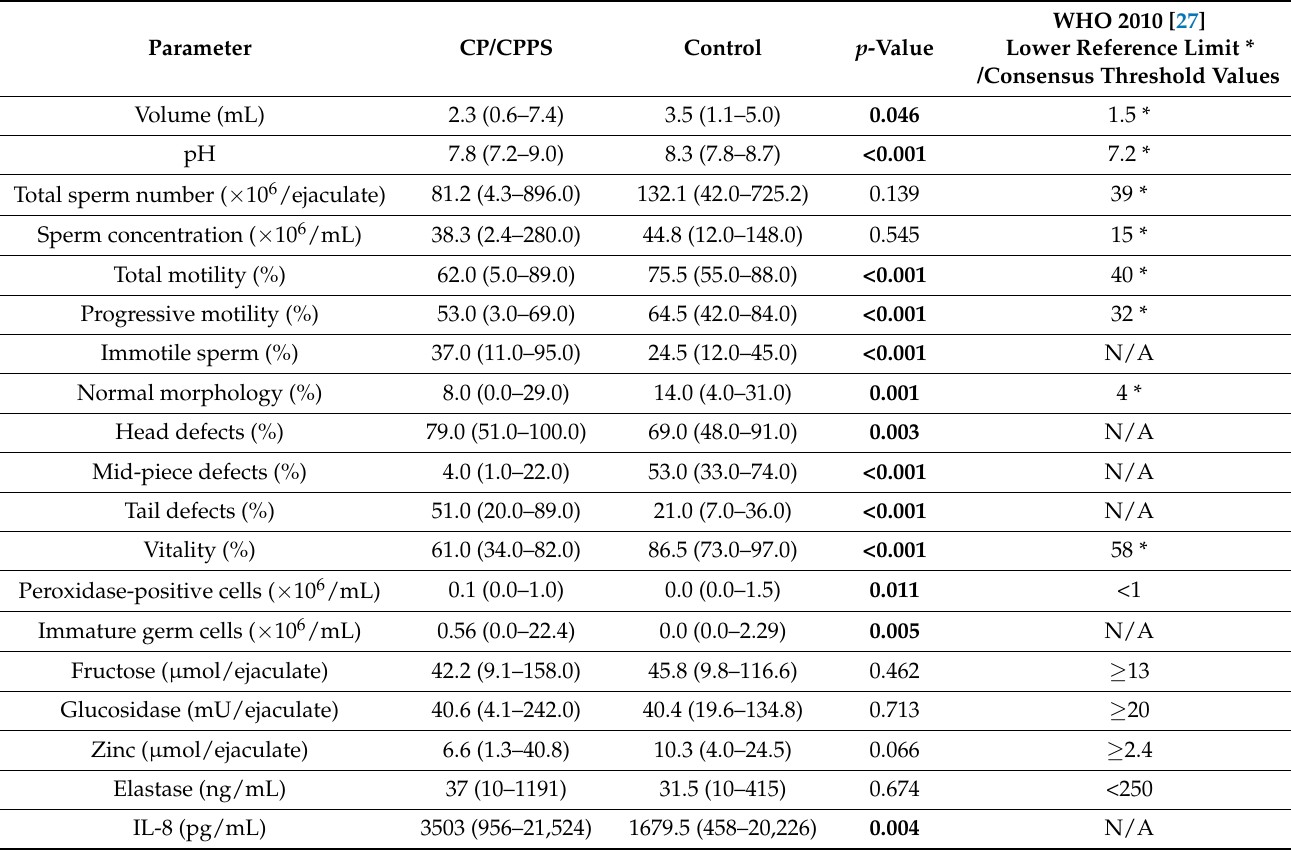
Table 1. Basic semen parameters and biochemical ejaculate parameters of CP/CPPS patients and healthy controls (median values and ranges are